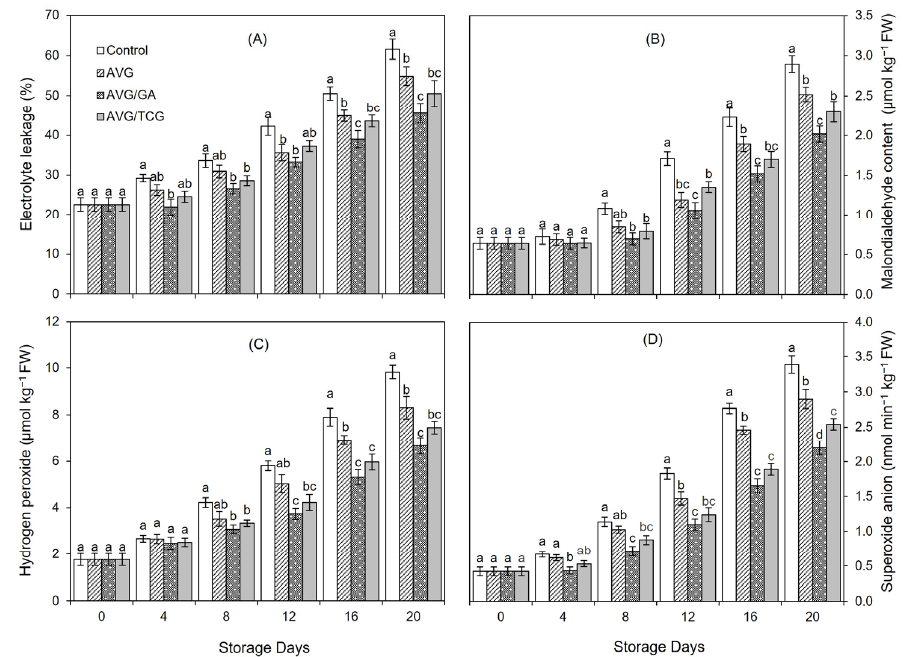
Figure 3. Effect of AVG-based composite coatings on electrolyte leakage ( A ), malondialdehyde content ( B ) hydrogen peroxide ( C ) and superoxide anion content ( D ) of persimmon fruits during 20 days storage (analysis on day 0, 4, 8, 12, 16 and 20) at 20 ± 1 ◦ C and 80–85% relative humidity. All standard error bars are centered on means (3 biological replicates). Graph bars sharing same letters on a storage interval have non ‐ significance difference according to the LSD test at p ≤ 0.05.